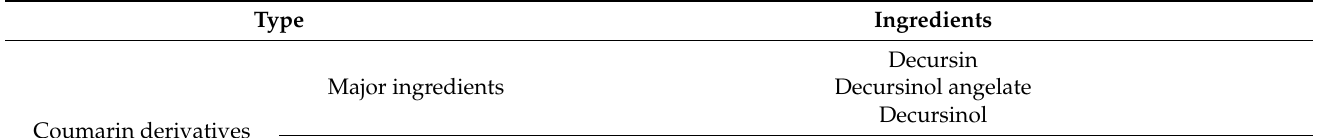
Table 1. Ingredients of Angelica gigas Nakai root extract (AGNE).